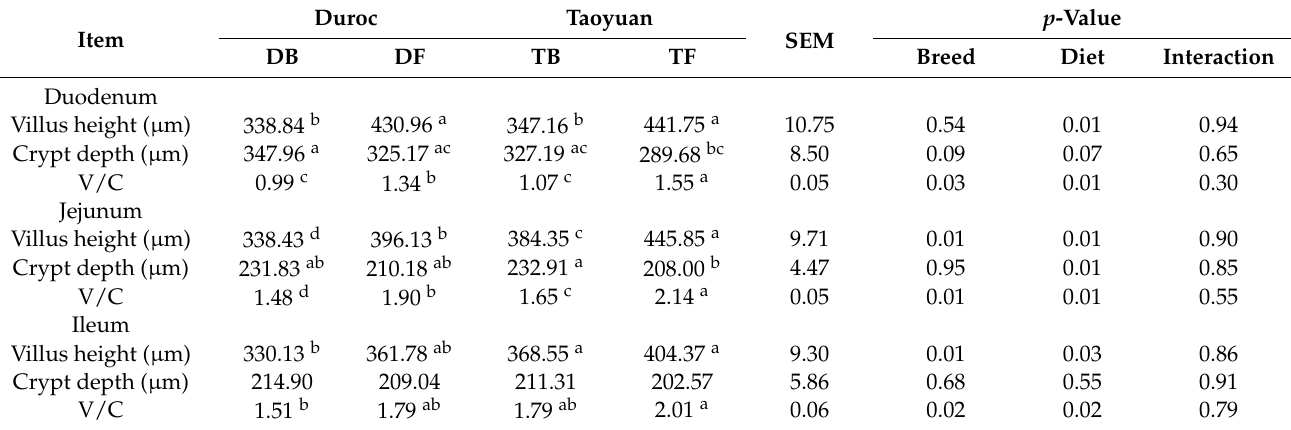
Table 4. Effects of DF on intestinal morphology.